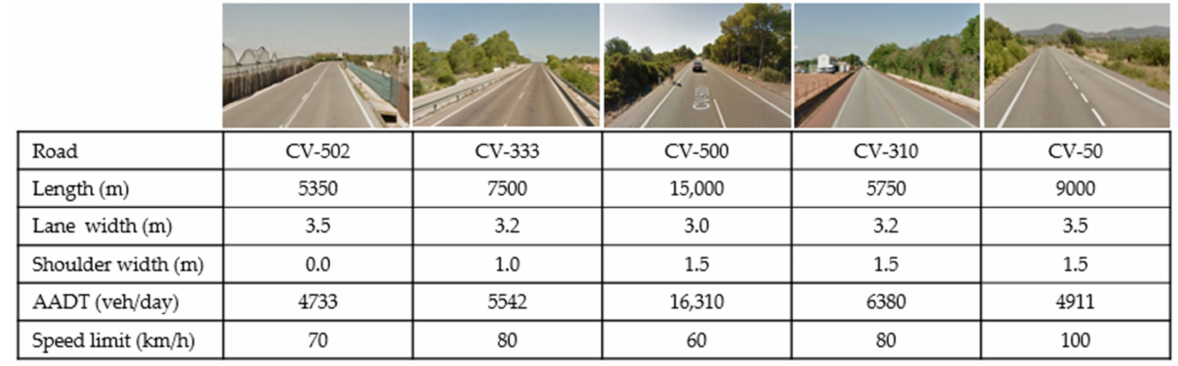
Figure 1. Characteristics of the five two-lane rural road segments where the study was developed.